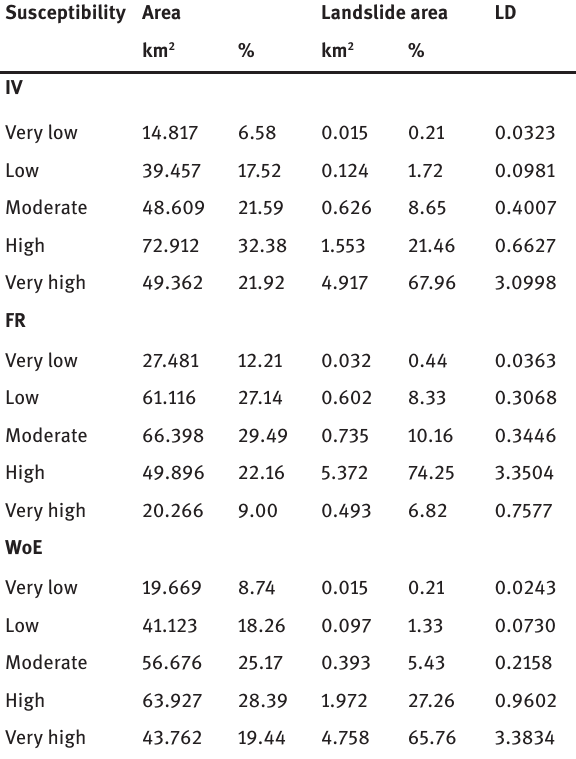
Table 2: LD in different susceptibility zones of the study area (IV, WoE,